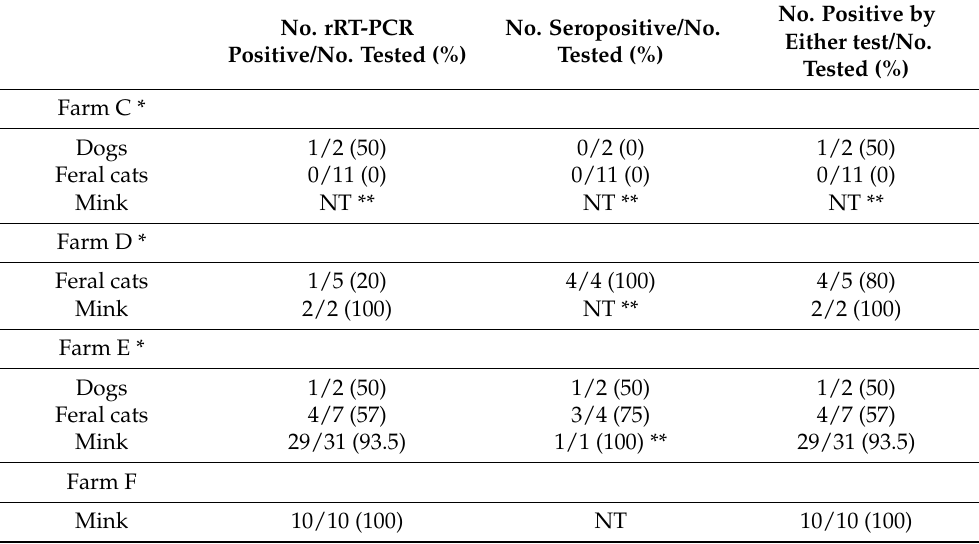
Table 3. Summary of animal SARS-CoV-2 rRT-PCR and serology results by farm and species in four Utah farms (Farms C to F) that experienced increased mortality in their mink herds